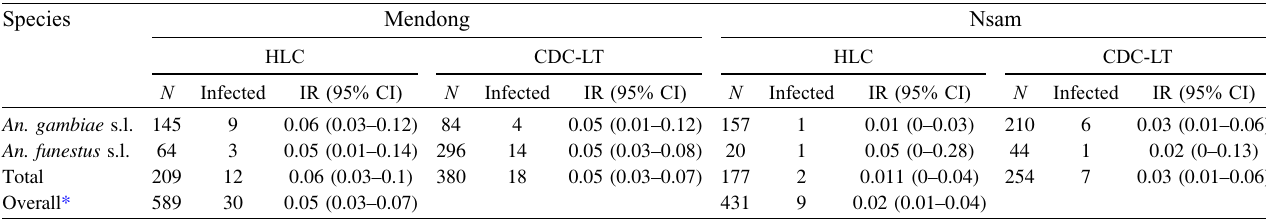
Table 5. Plasmodium falciparum infection rate of mosquitoes collected using HLCs and CDC-LTs in Nsam and Mendong. Species